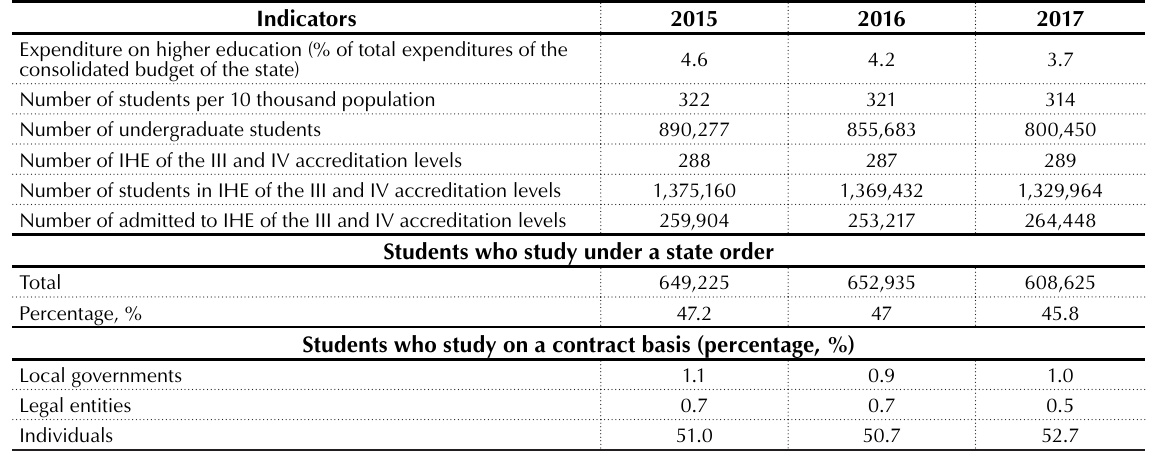
Table 1. Main indicators of higher education in Ukraine Source: Developed by the authors on the basis of State Statistics Service of Ukraine